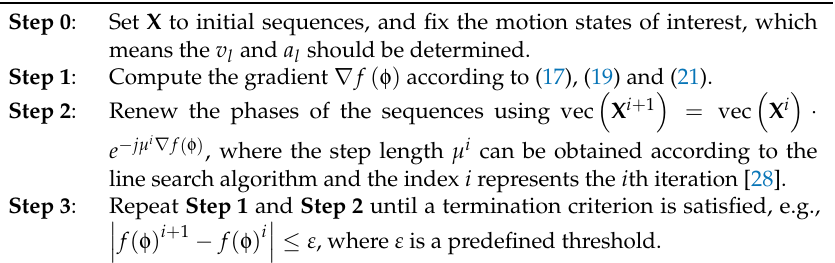
Table 2. Steps for the IAG